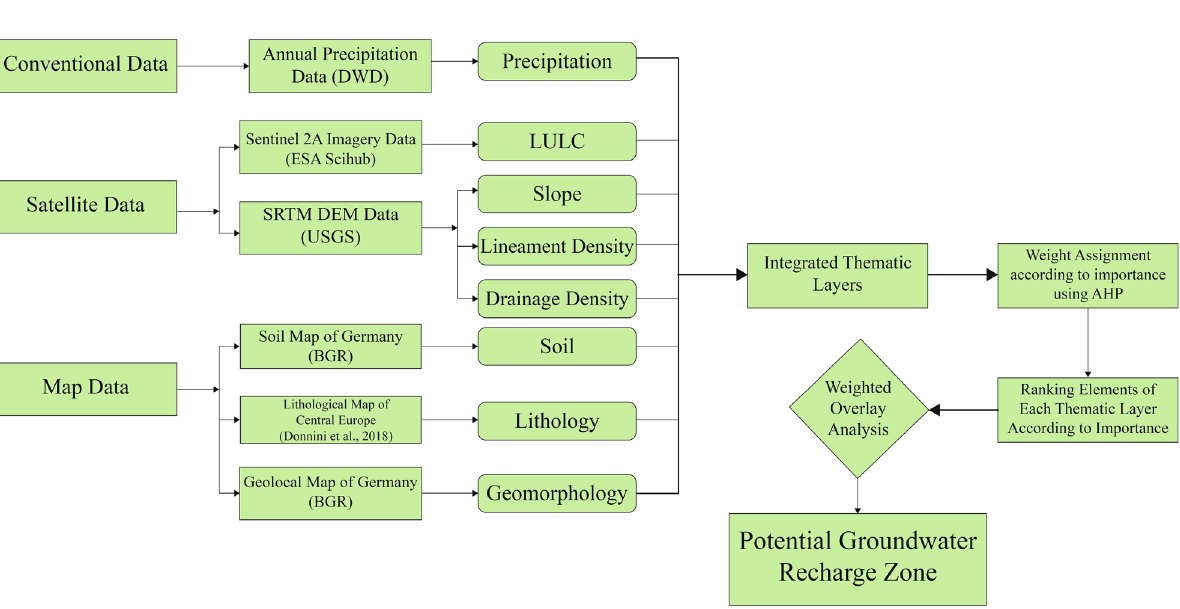
Figure 3. Workflow for potential groundwater recharge zone